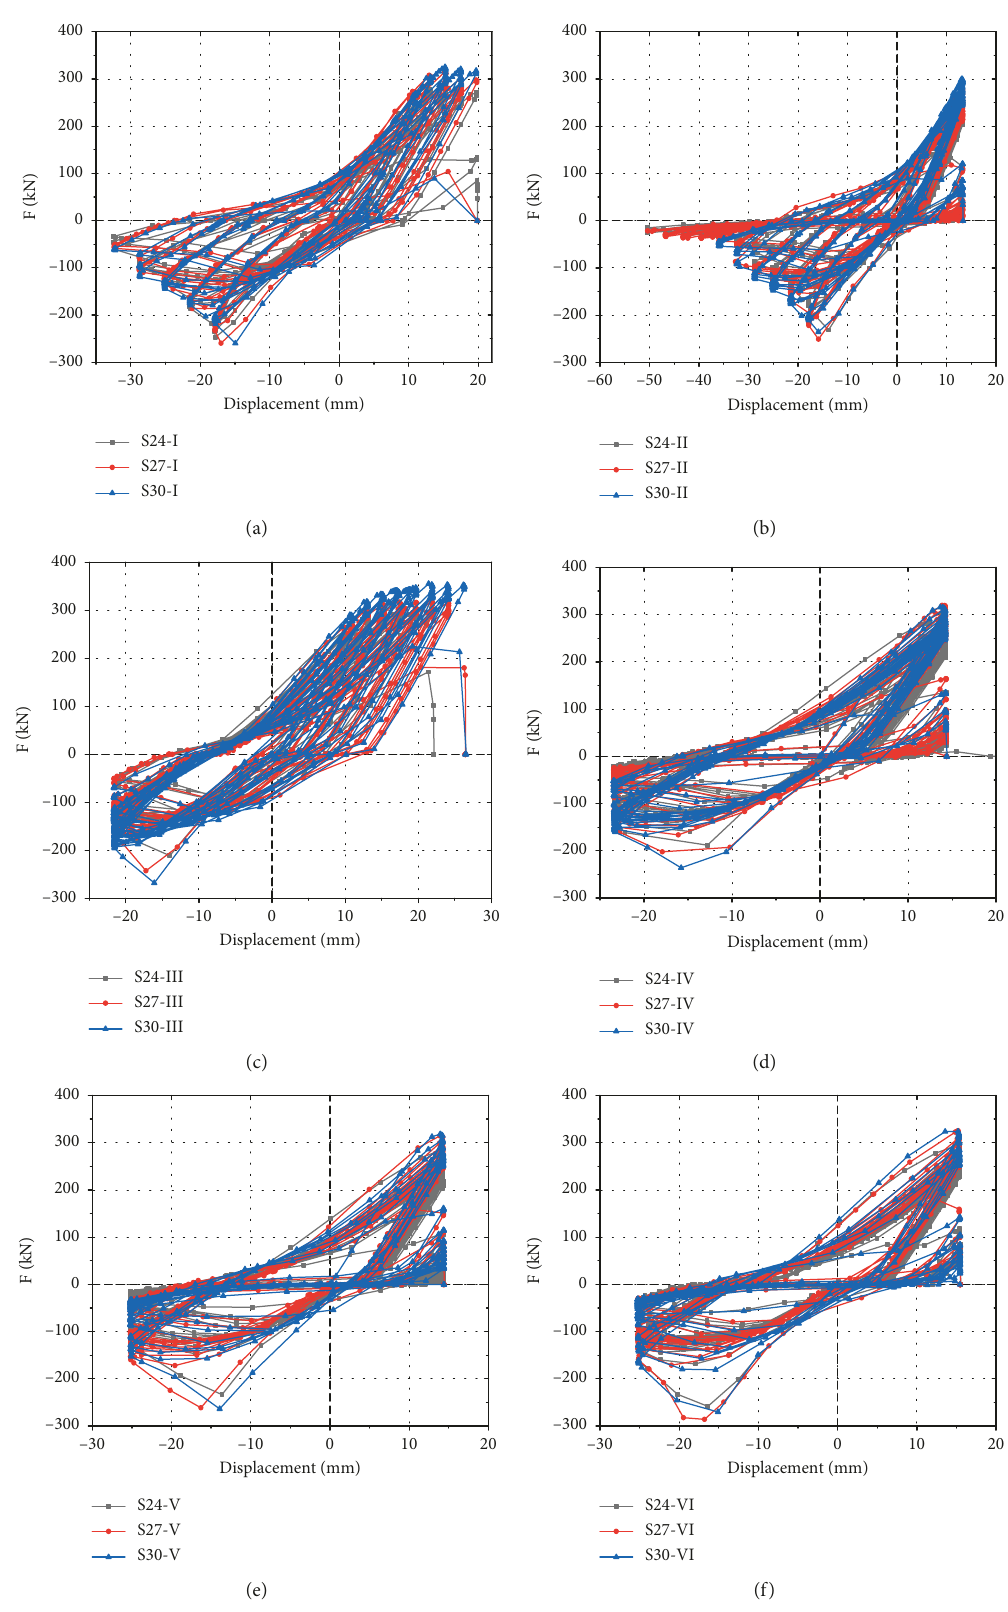
Figure 13: Comparison of load-displacement hysteretic curves at ends of composite specimens. (a) Hysteretic curve under system. (b) Hysteretic curve under system II. (c) Hysteretic curve under system III. (d) Hysteretic curve under system IV. (e) Hysteretic curve under system V. (f) Hysteretic curve under system